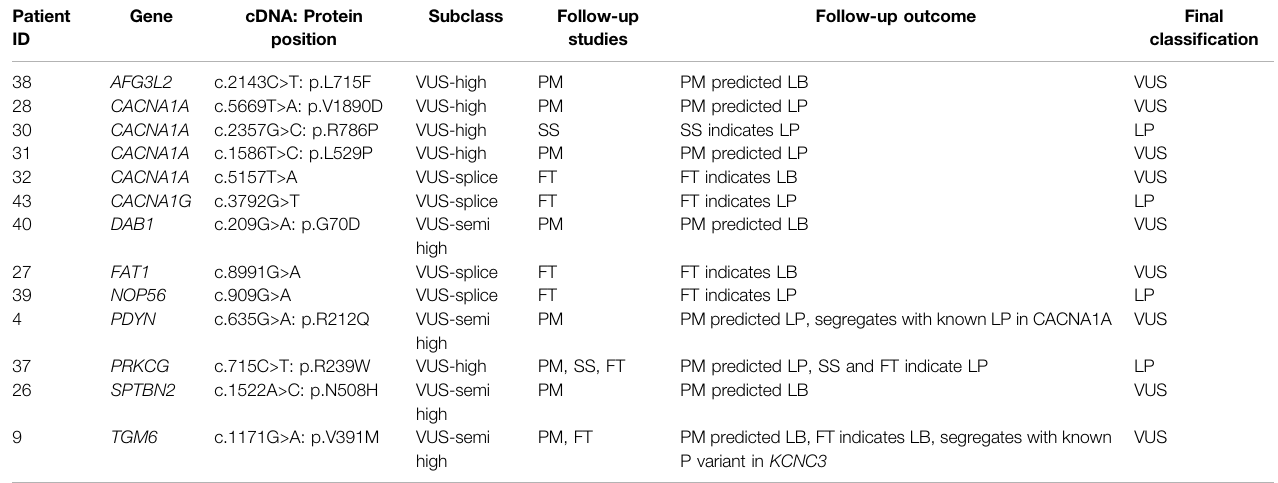
TABLE 4 | Reclassi fi cation of VUSes based on follow-up studies. Patient